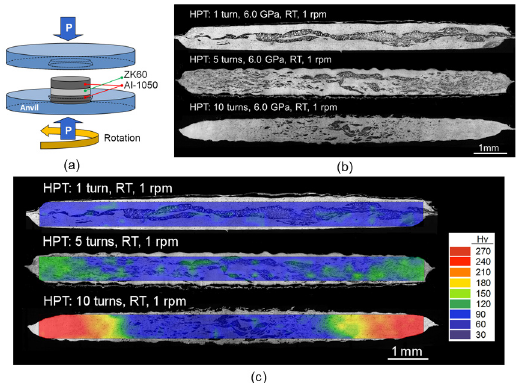
Figure 1. (a) Schematic illustration of the sample set-up for HPT processing and (b) an overview of the microstructure and (c) color- coded hardness contour maps taken at the vertical cross-sections along the disk diameters after HPT for 1, 5 and 10 turns, respectively. 17-19